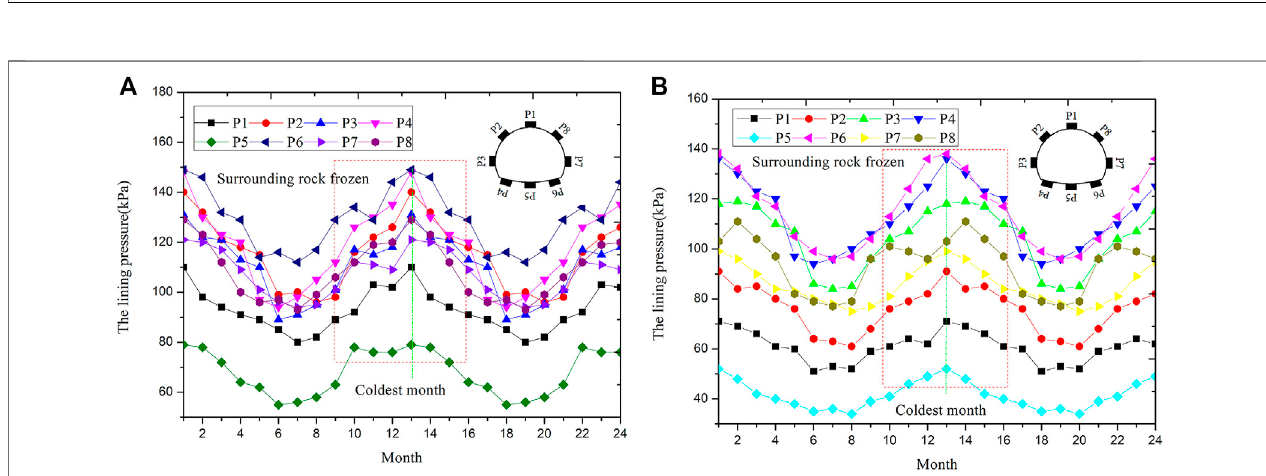
FIGURE 3 | Radial temperature change rule of surrounding rock. (A) Section 700-line CW (B) Section 700-line DW (C) Section 600-line CW (D) Section 600- line DW.